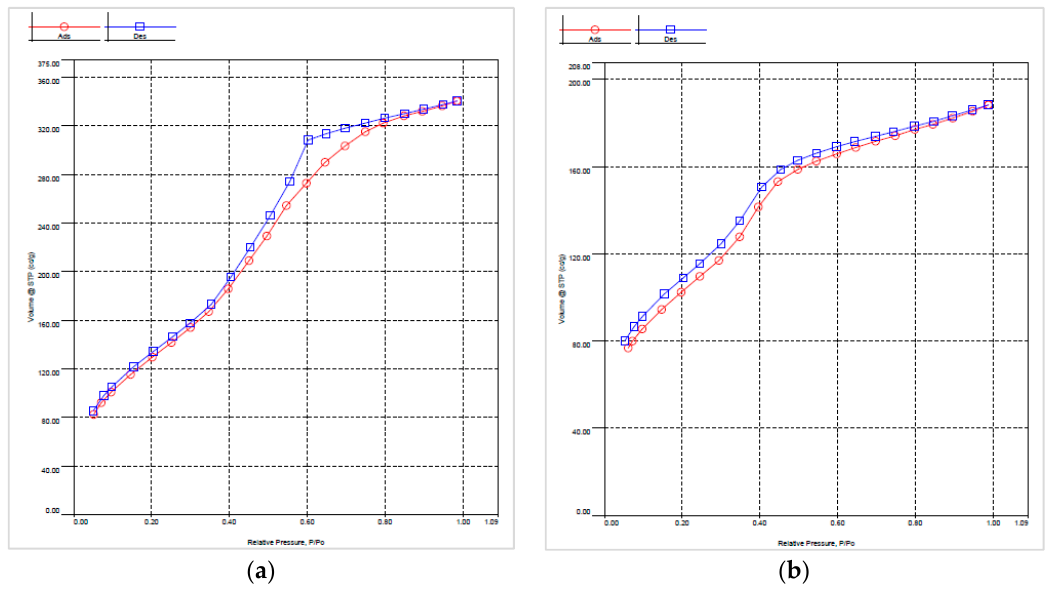
Figure 9. N 2 adsorption–desorption isotherms of ( a ) chiral PMO NPs and ( b ) magnetic chiral PMO NPs.